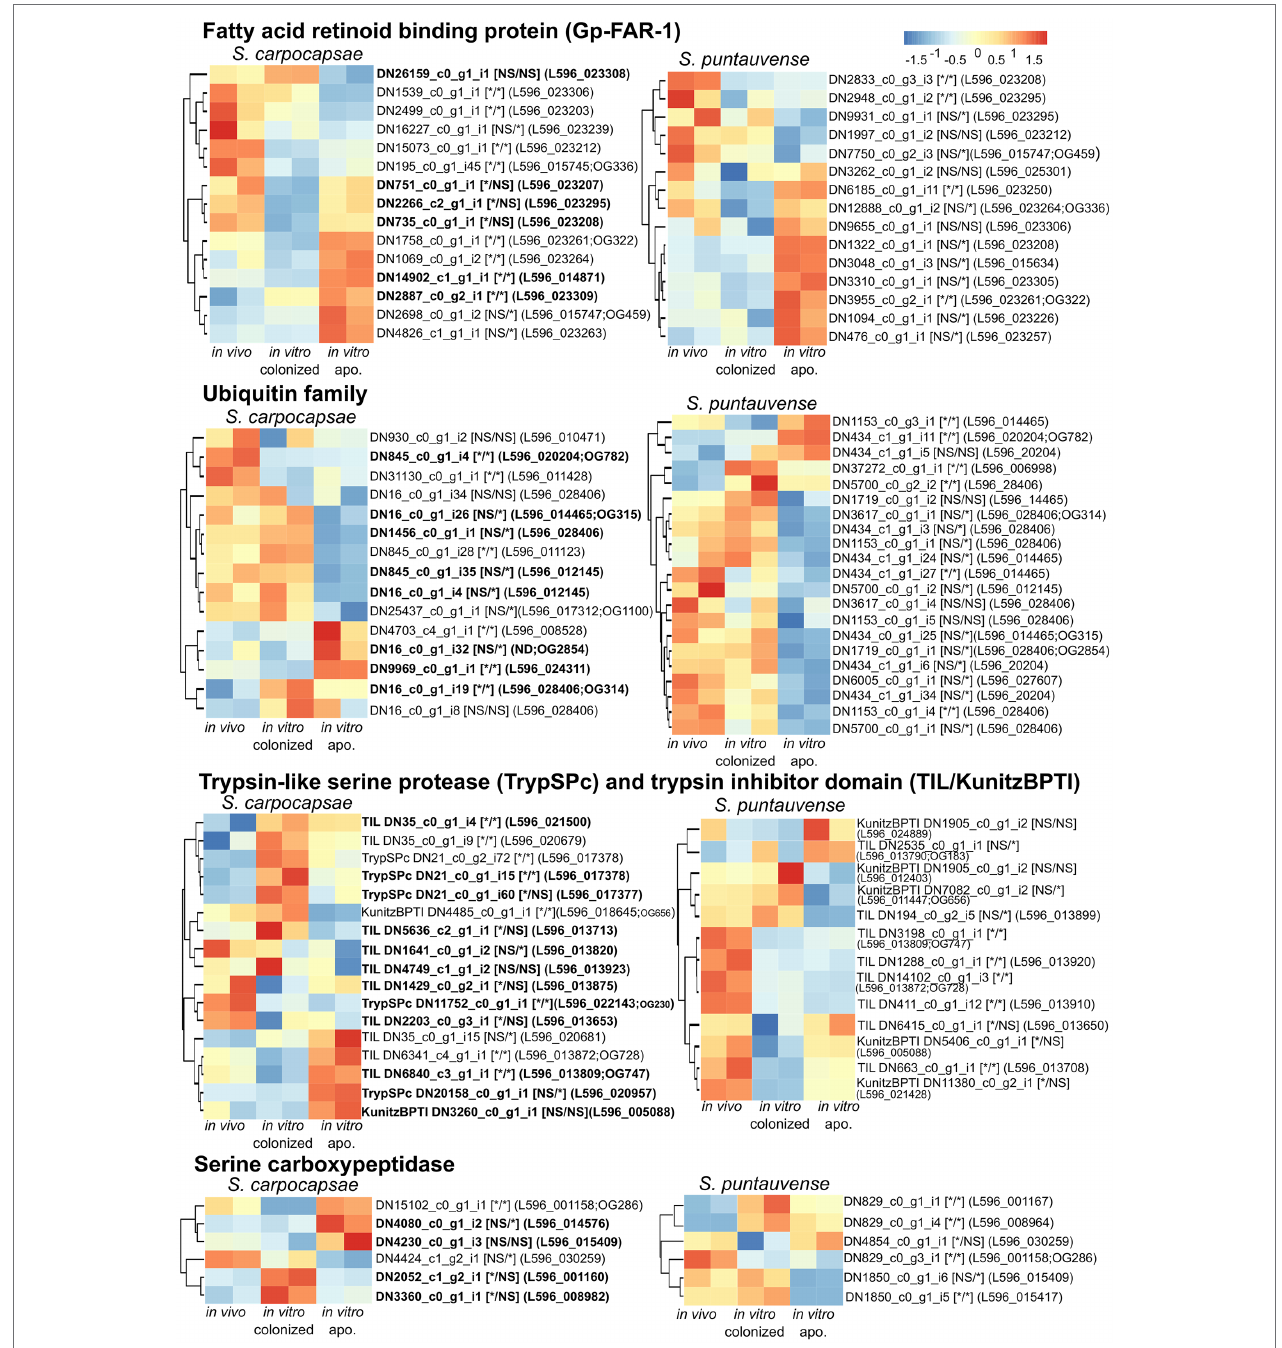
FIGURE 11 | Heatmap of expression of transcripts identified as Fatty acid and retinoid binding protein, ubiquitin, trypsin-like serine protease, trypsin inhibitor domain and serine carboxypeptidase by pheatmap. On the right side of the heatmap supplementary information is indicated: the name of the transcript; significance of differentially expression based on cuffdiff and edgeR (“*” denotes statistically significant difference, NS indicates no significant difference), first value for the in vitro colonized rearing condition and the second value for the in vitro aposymbiotic rearing condition; homologous genes in S. carpocapsae genome; if applicable the name of the orthogroup of transcript shared among the two species (based on orthofinder analysis) is